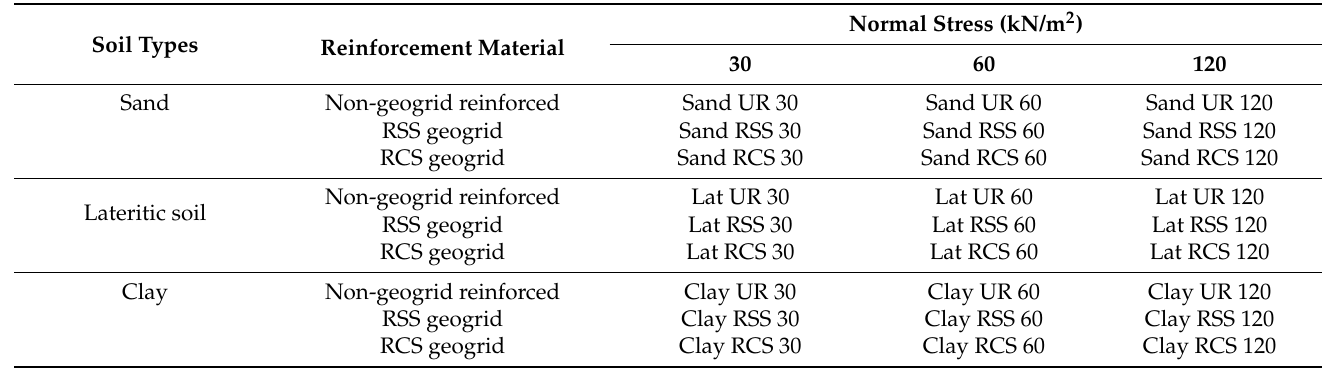
Table 3. Testing